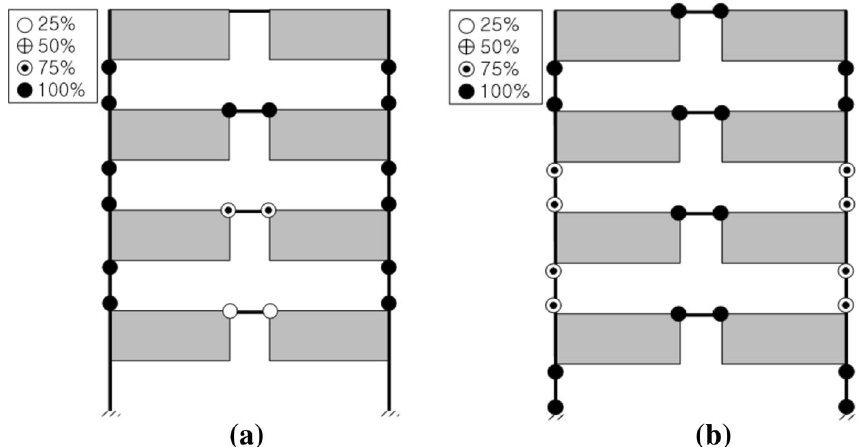
Fig. 16 Plastic hinge formation in the model structures at the maximum inter-story drift ratio of 2.5%. a Strength-designed model and b capacity designed model.